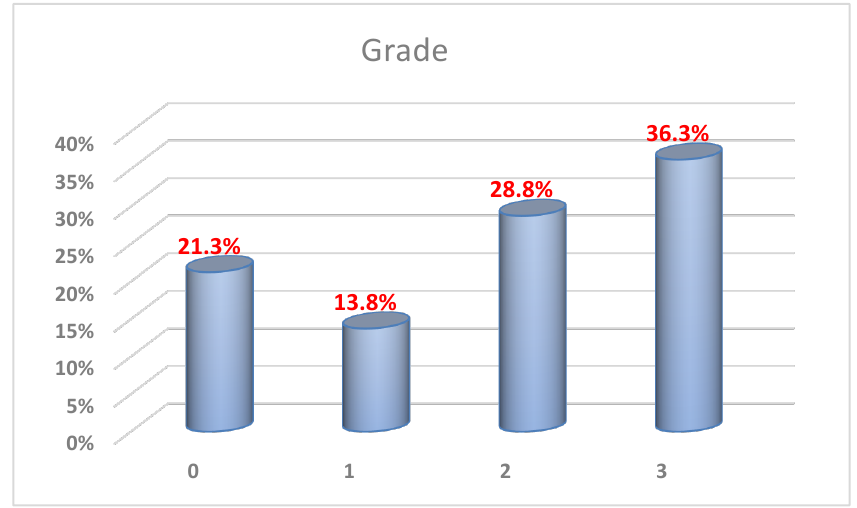
Figure 9. Percentages of selected adapted buildings according to their grade.